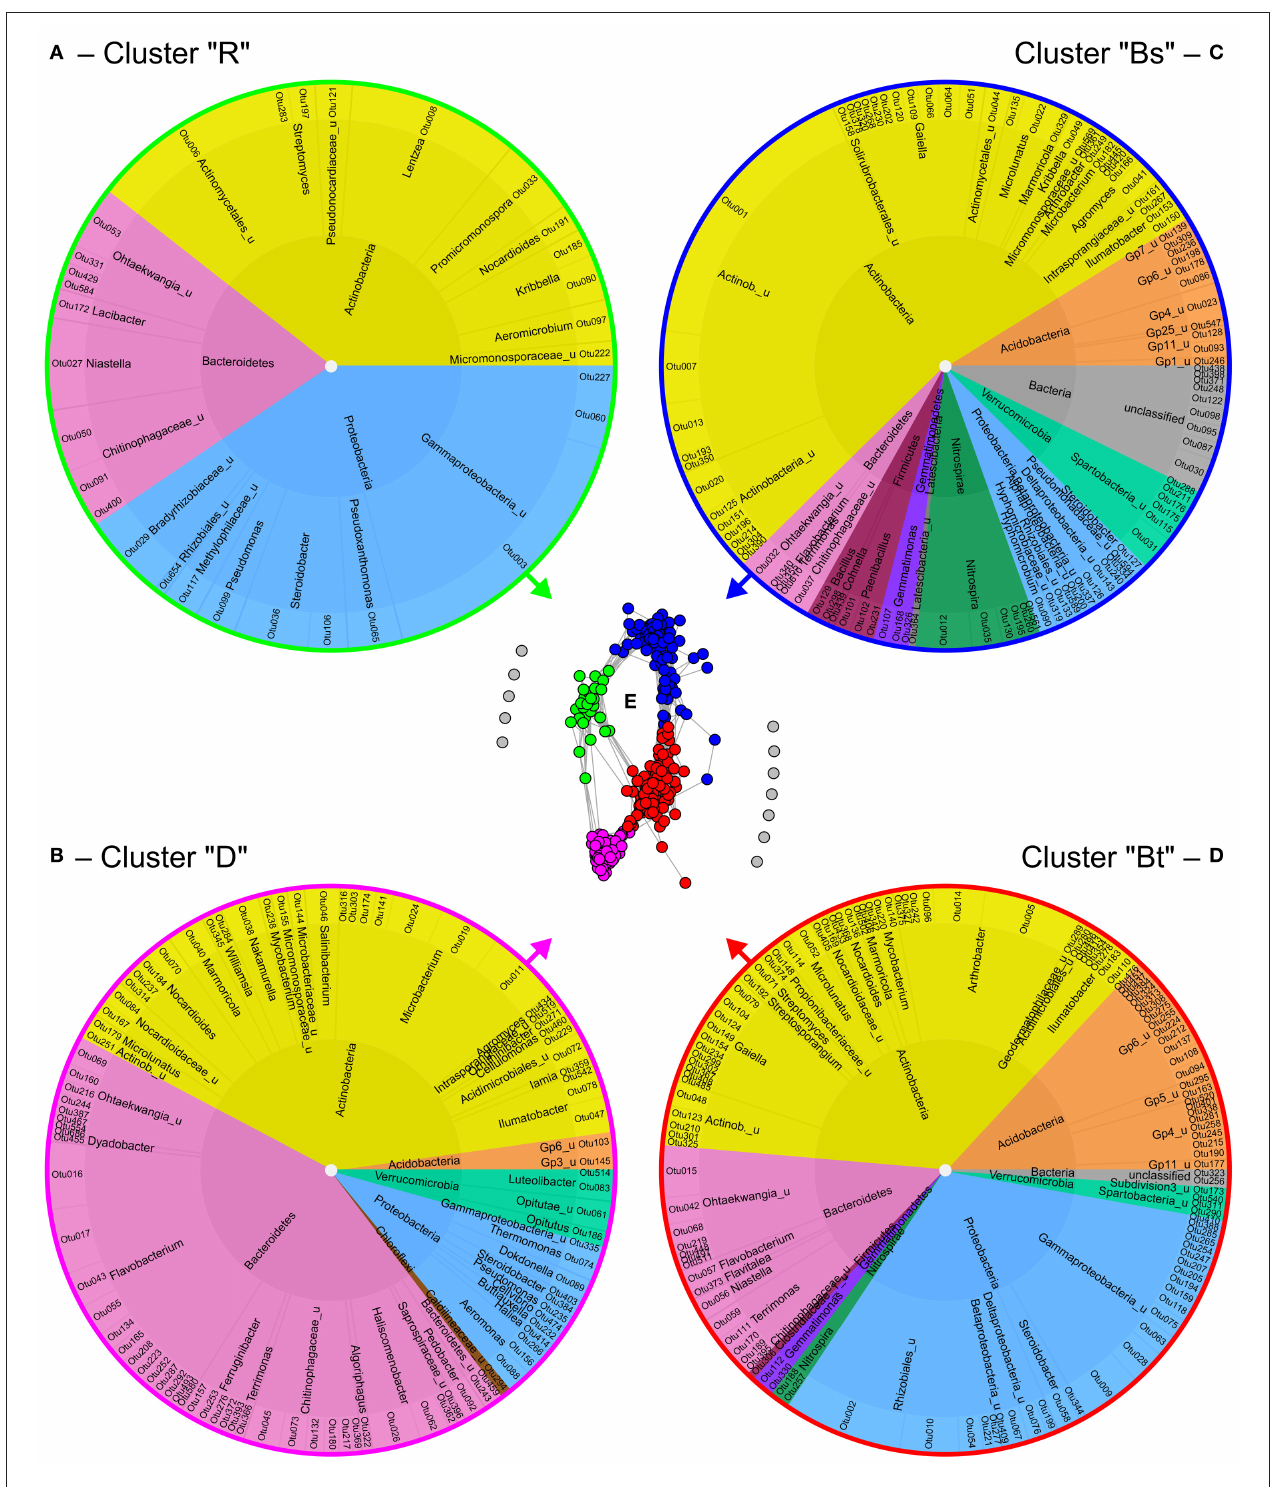
FIGURE 5 | Formation and composition of bacterial clusters of co-occurring OTUs (A–D) as revealed by network analysis (E). Each dot in the network represents one OTU at 95% similarity level and each connecting line a positive correlation with Spearman’s rank correlation coefficient > 0.6. For the gray colored OTUs in the network no positive correlations were found. Inner ring—phylum level; middle ring—genus or nearest classifiable level. R, rhizosphere; D, drilosphere; Bs, bulk subsoil; Bt, bulk topsoil.